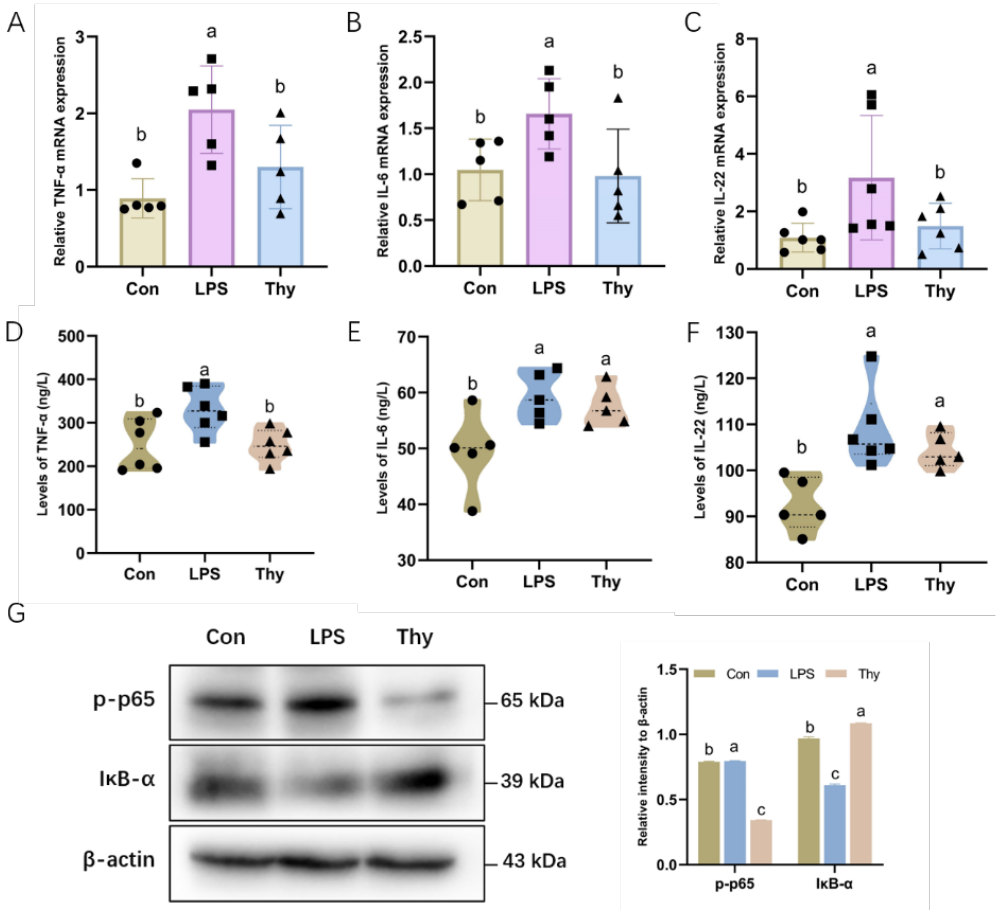
Figure 2. Thymol ameliorates LPS-induced inflammation. The mRNA levels of inflammatory cytokines ( A ) TNF- α ; ( B ) IL-6; and ( C ) IL-22 in the liver ( n = 5–6). The concentration of ( D ) TNF- α ; ( E ) IL-6; and ( F ) IL-22 in the liver, as determined by ELISA analysis ( n = 5–6). ( G ) The expression and quantification of p-p65 and I κ B- α in the liver as determined by Western blotting. Values are normalized to β -actin levels and expressed as the mean ± SD ( n = 6). Con, control; Thy, thymol. Differences were presented with different superscript letters ( p < 0.05).